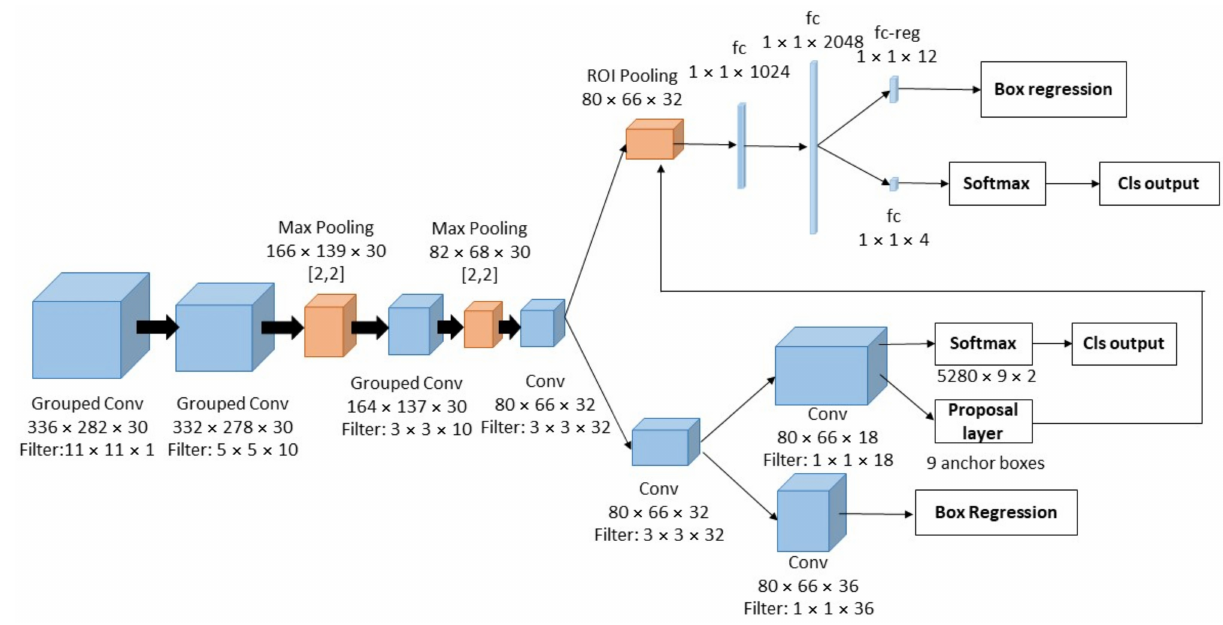
Figure 4. Pelvis NN for metastasis classification. We applied three NN models for